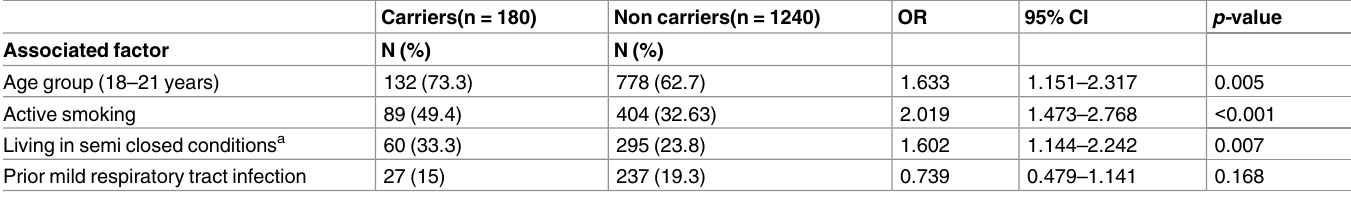
Table 1. Factors associated with meningococcal carriagein the studied